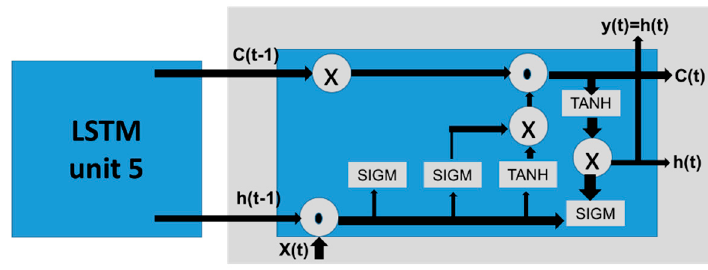
Figure 4. Long short-term memory (LSTM) architecture [20].